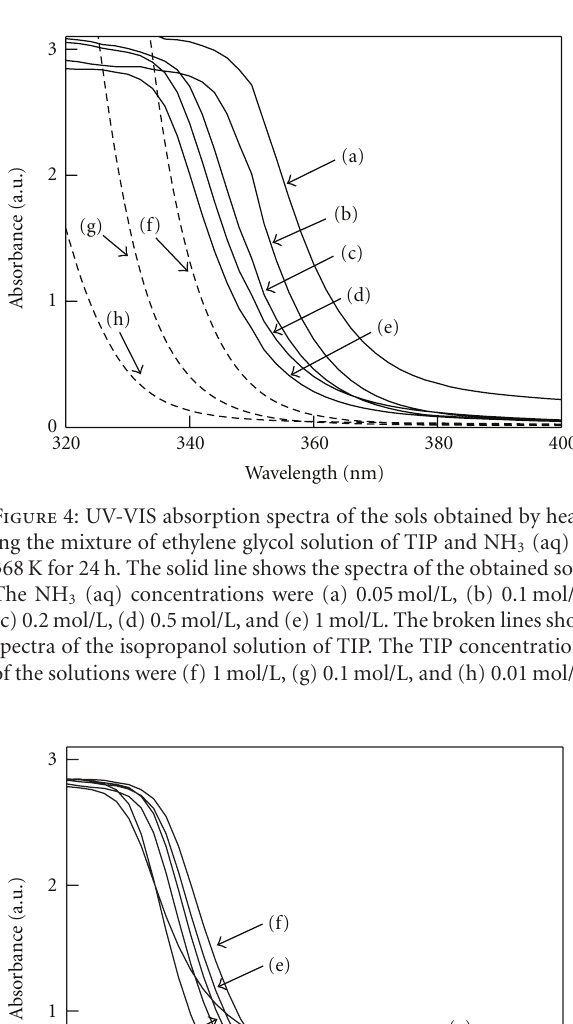
0.1 mol/L and 1 mol/L of the NH 3 (aq). Additionally, a